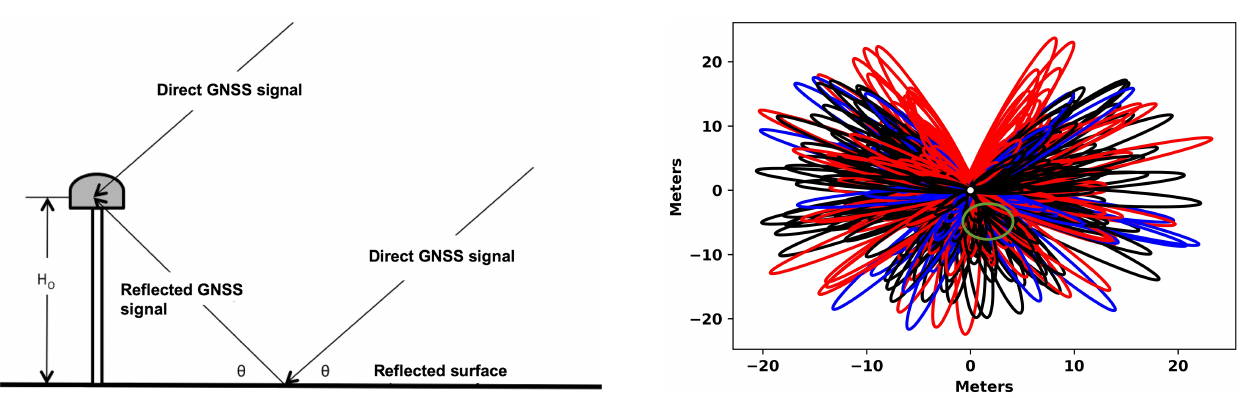
Figure 2. GNSS Fresnel ellipses around the geodetic antenna during one of the observation days. GPS constellations satellites are shown in black, GLONASS satellites are shown in red, and GALILEO satellites are shown in blue. The green circle is the loca- tion where the soil samples have been